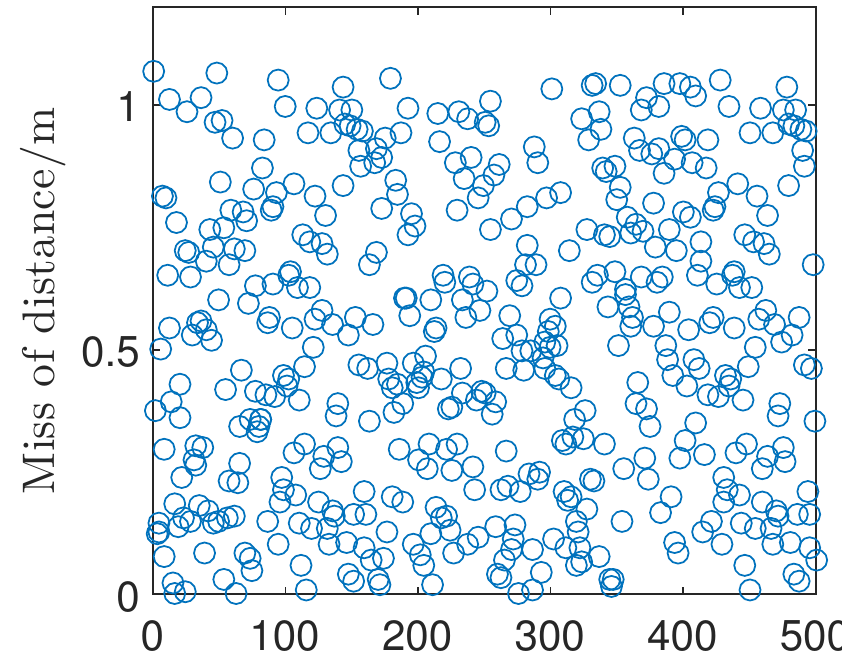
Figure 15. Curve of the missed distance in the Monte-Carlo